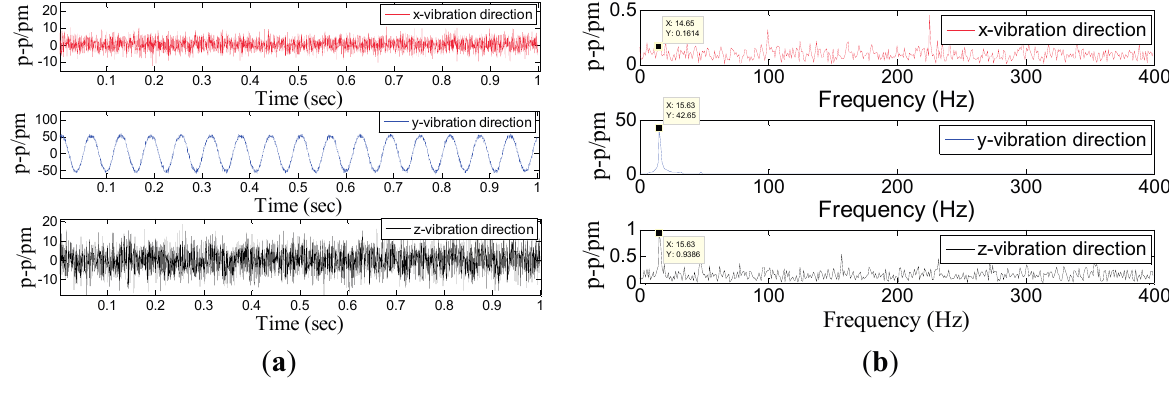
Figure 10. Response of the three directions under y -direction excitation with the acceleration — 1m/s 2 -16Hz. ( a ) Time domain response map. ( b ) Spectrum map.